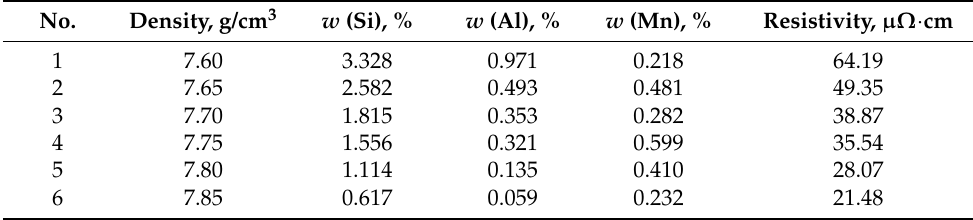
Table 1. Nominal density, averaged chemical composition and resistivity.